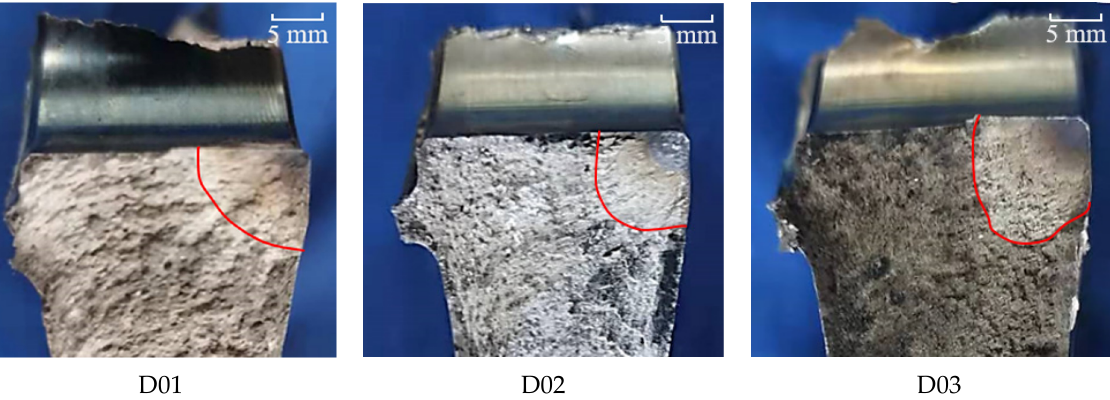
Figure 28. Fracture morphology of D01, D02 and D03.